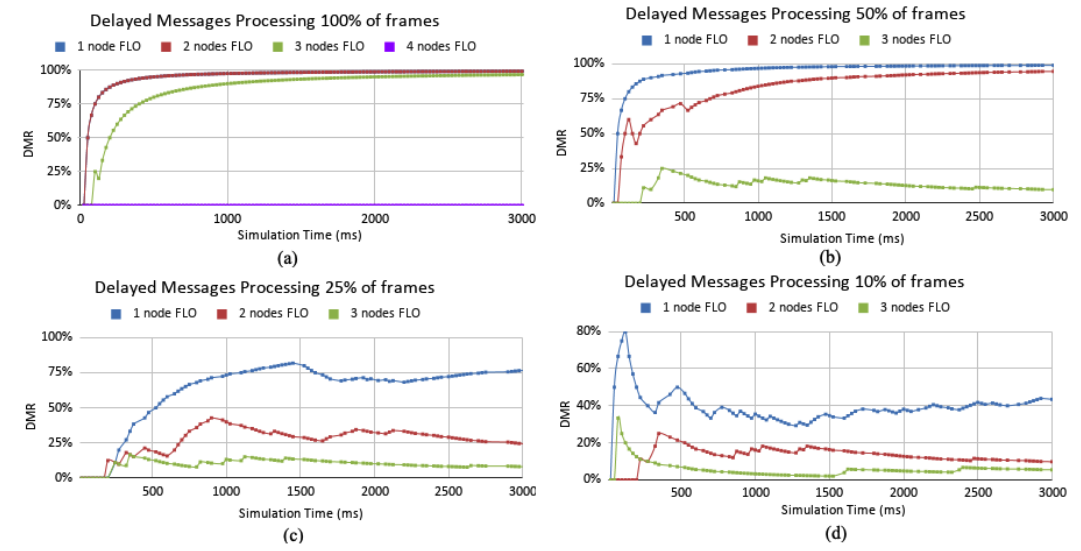
Figure 7. Workflow Time Processing considering: ( a ) 100%; ( b ) 50%; ( c ) 25%; and ( d ) 10% of the frames are images of